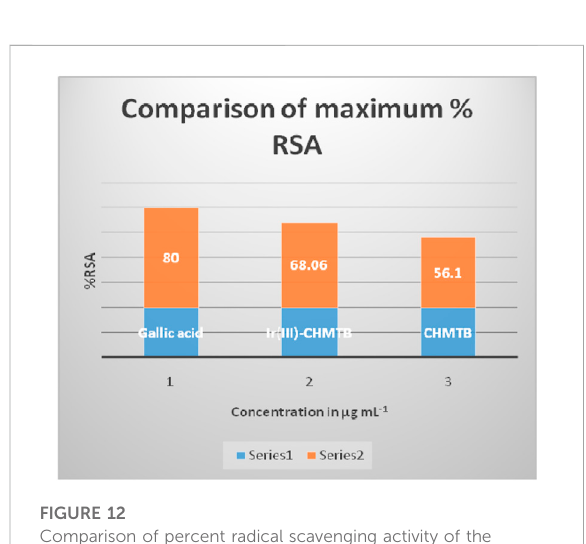
FIGURE 12 Comparison of percent radical scavenging activity of the selected